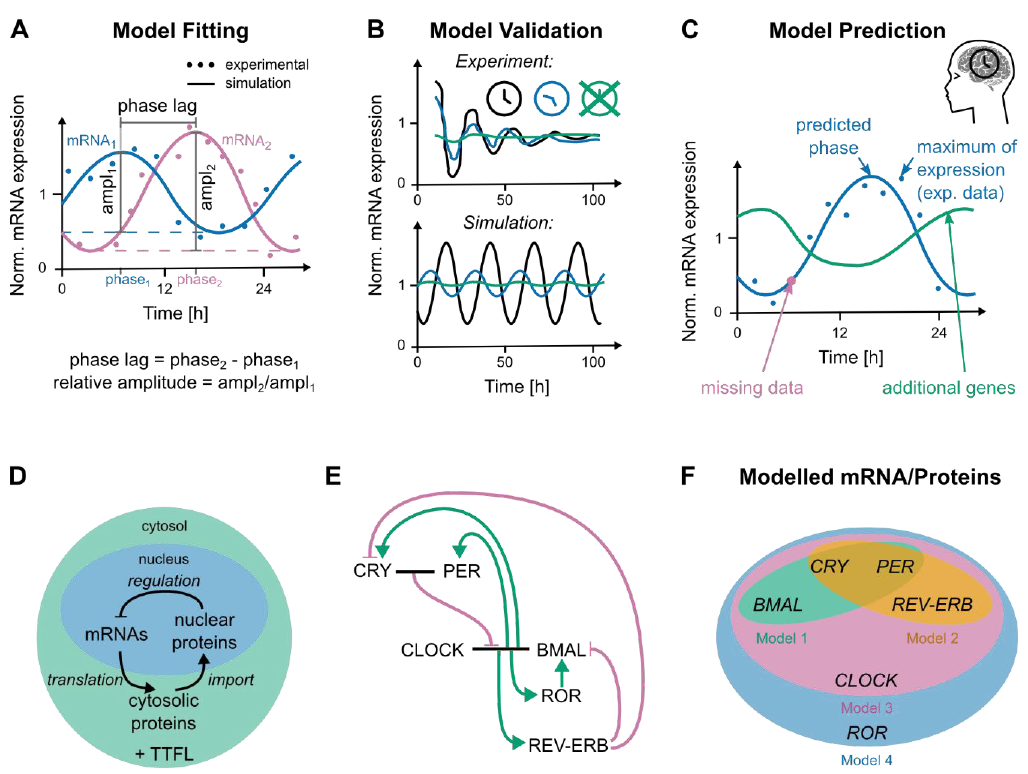
Figure 5. Basic mechanisms of genetic core-clock models. ( A ) Adapting the parameters of the model, the simulated model (blue and pink lines) can be fitted to experimental or clinical data (blue and pink dots). ( B ) After fitting, the model is validated by predicting, for example, whether or not oscillations are observed for known knock-out scenarios. ( C ) The model can be used to directly predict the circadian phenotype or to derive features for a subsequent prediction, such as additional data points or unobserved data. ( D ) The negative feedback loop in the circadian clock is based on an mRNA, which, translated to a cytosolic protein, is imported to the nucleus, where the nuclear protein inhibits the subsequent transcription of its target mRNA. ( E ) The basic interactions between different genes in the core-clock network. Each node represents a simplification of the translation/importing steps depicted in D. Green lines represent activation reactions, pink lines inhibitions and black lines complex formation. ( F ) Published molecular models of the core-clock implement different sets of core-clock genes. Models were selected for mammalian parameters and a focus on core-clock gene dynamics. Model 1, Becker-Weimann et al. 2004 [190]; Model 2, Forger et al. 2003 [189]; Model 3, Leloup et al. 2003 [188]; Model 4, Mirsky et al. 2009 [191]; Relógio et al. 2011 [23].